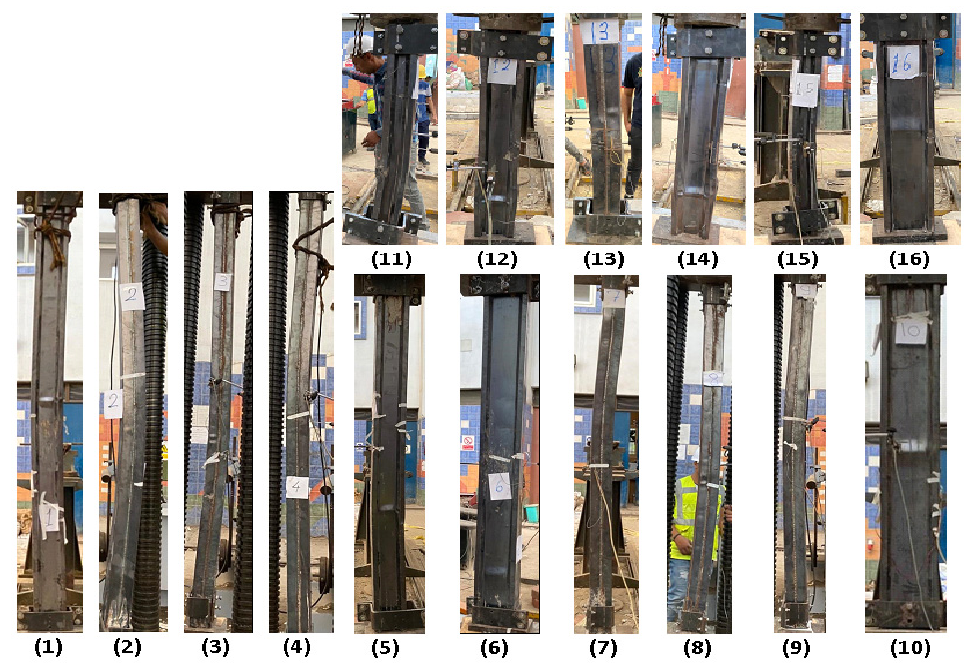
Figure 4. Failure modes of tested specimens.